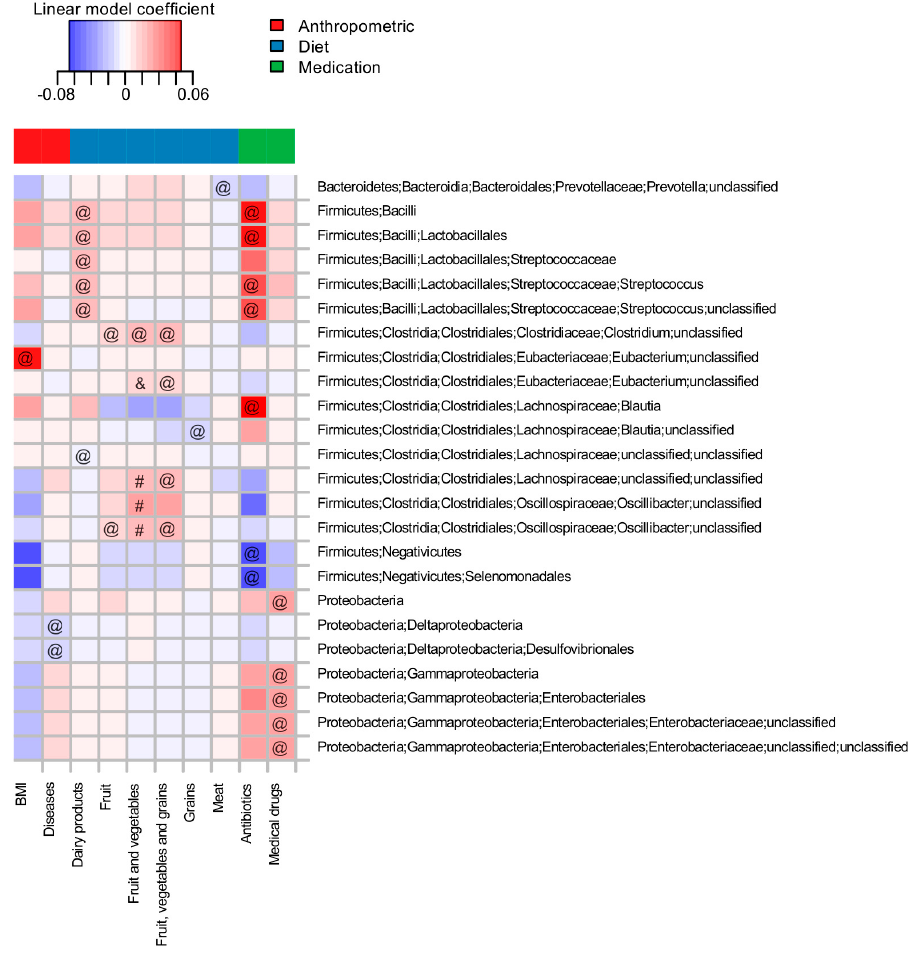
Figure 1. Associations of the microbial taxa with long-term dietary habits and other factors from the questionnaire ( n = 207 subjects). Analysis was performed for the baseline samples at taxonomic levels from species to phyla. Rows are sorted in alphabetic order. Cell color denotes the value of the linear model coefficient from the MaAsLin analysis. All significant associations (FDR adjusted p < 0.1) are marked with one of the symbols (&, #, @): “&”—associations previously reported by Zhernakova et al., 2016 [41], “#”—reported by Wu et al., 2011 [13], “@”—novel associations.